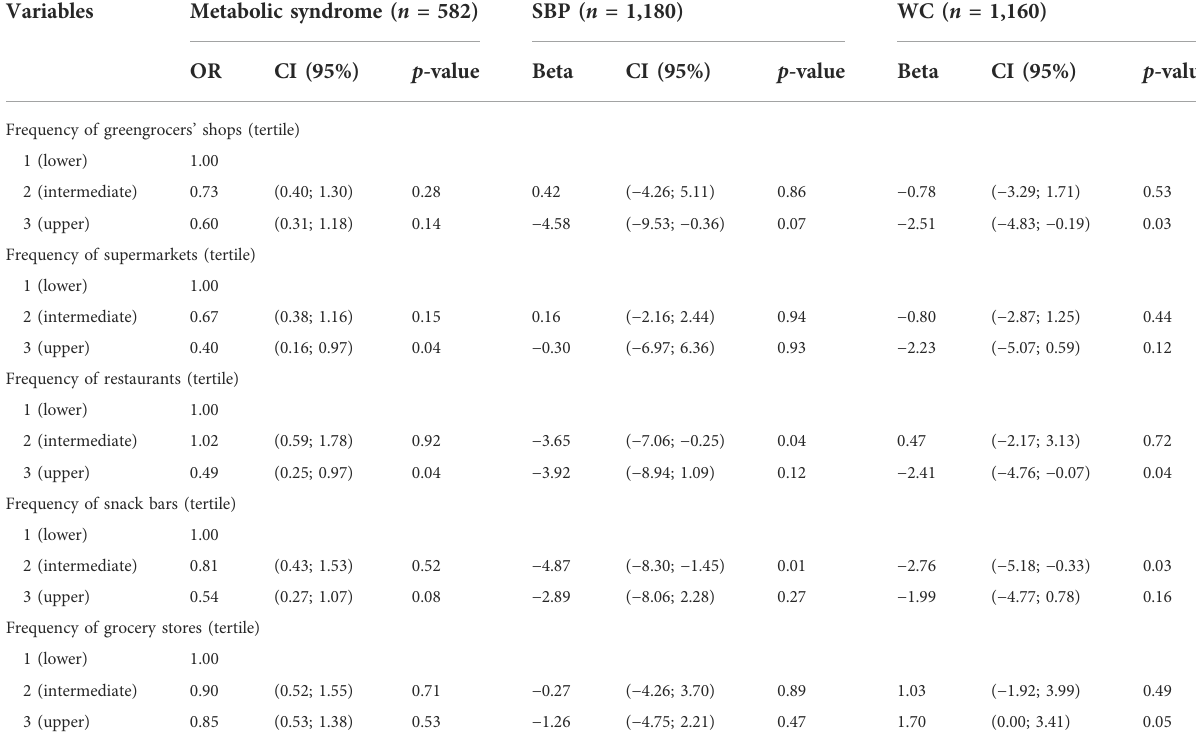
TABLE 3 Association between the frequency of establishments in the vicinity and metabolic syndrome, systolic blood pressure, and waist circumference in the older adults of the EpiFloripa Aging Cohort Study — Wave 2 in Florianópolis, SC, 2013 – 2014